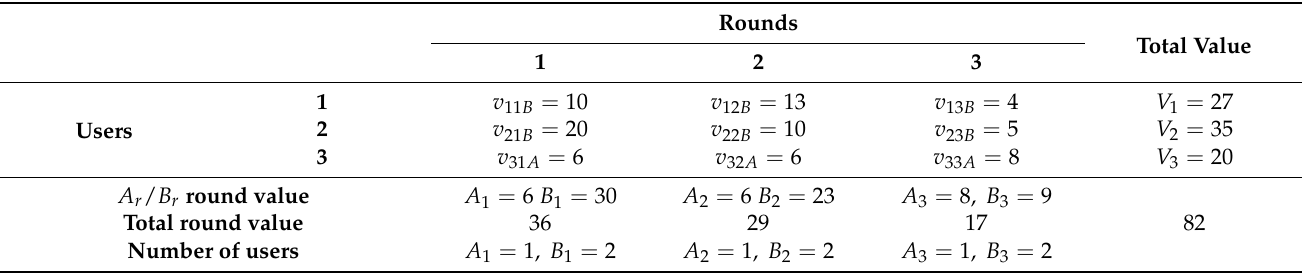
Table 3. Alternative users’ values with three voting